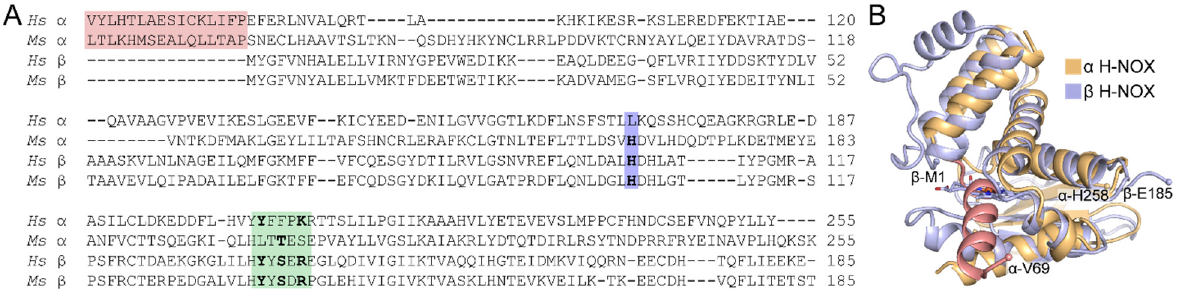
Figure 5. An N-terminal extension of the α H-NOX domain occludes heme binding. ( A ) Sequence alignment of the α and β H-NOX domains from human ( Hs ) and moth ( Ms ) sGCs. The α and β H-NOX domains share 20 and 18% sequence identity for the human and moth sequences, respectively. The N-terminal extension of the α H-NOX domain that is visible in the human sGC EM structure is highlighted in pink. The heme-ligating histidine ( β -His105) and the YxSxR motif of the β H-NOX domain are highlighted in blue and green, respectively. Functionally conserved residues are in bold font. ( B ) Superposition of the α and β H-NOX domains from the unactivated human sGC structure (PDB ID 6JT0 [65]). The N-terminal helical extension of the α H-NOX domain is shown in pink and clashes with the heme in the β H-NOX domain. Structures were aligned by secondary structure matching (r.m.s.d. = 1.88 Å for 121 residues aligned). Protein is shown as in Figure 4 with the heme cofactor C atoms in light blue. The N- and C-terminal residues of each domain are labeled and shown as small spheres.